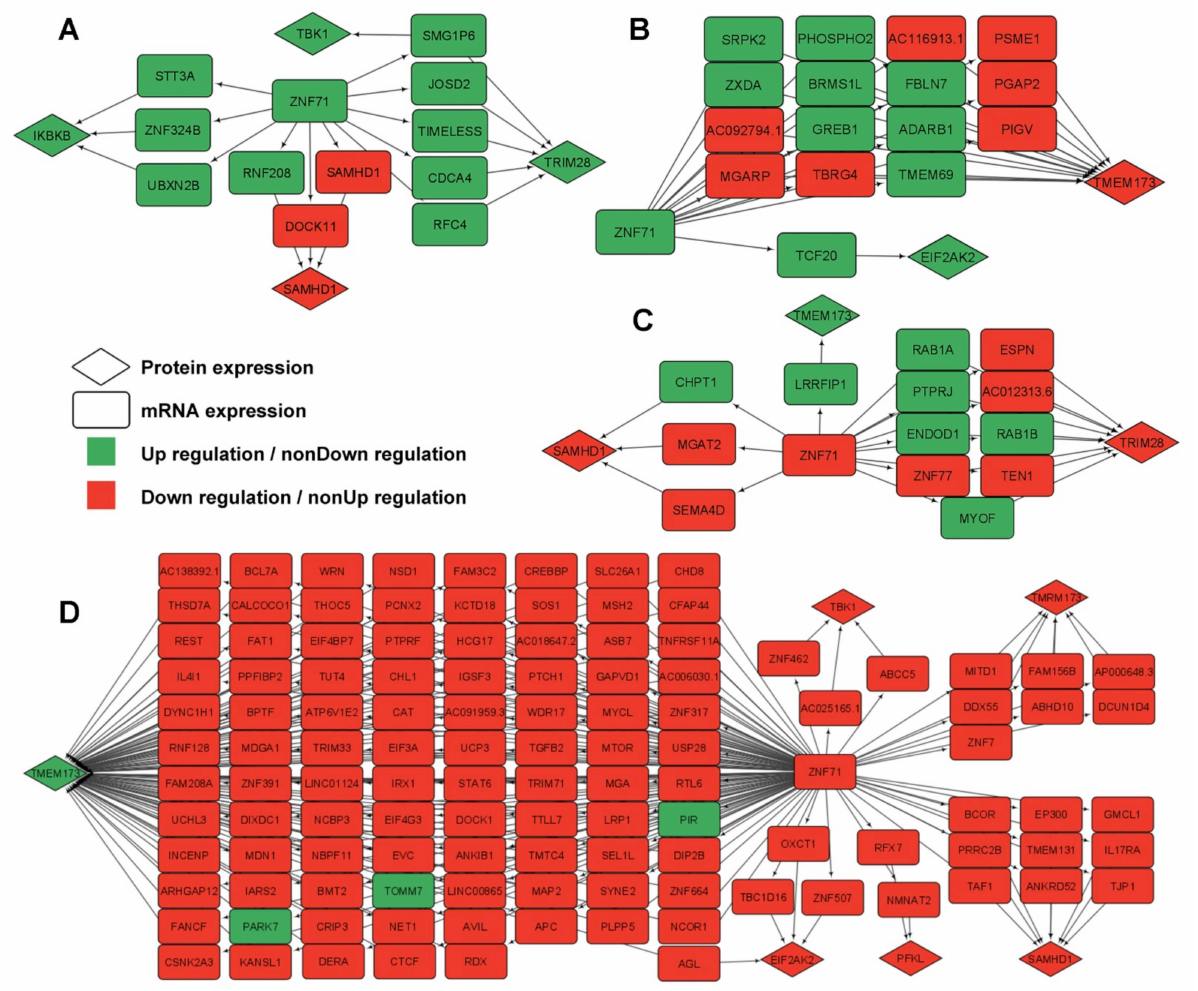
Figure 7. Multi-omics gene association networks of ZNF71 and intracellular innate immune response (IIIR) genes in lung adenocarcinoma (LUAD) patient samples using RNA sequencing and proteomics data. ( A ) Gene associations between ZNF71 and IIIR genes through intermediate genes in LUAD tumors when ZNF71 is upregulated. ( B ) Gene associations between ZNF71 and IIIR genes through intermediate genes in NATs when ZNF71 is upregulated. ( C ) Gene associations between ZNF71 and IIIR genes through intermediate genes in LUAD tumors when ZNF71 is downregulated. ( D ) Gene associations between ZNF71 and IIIR genes through intermediate genes in NATs when ZNF71 is